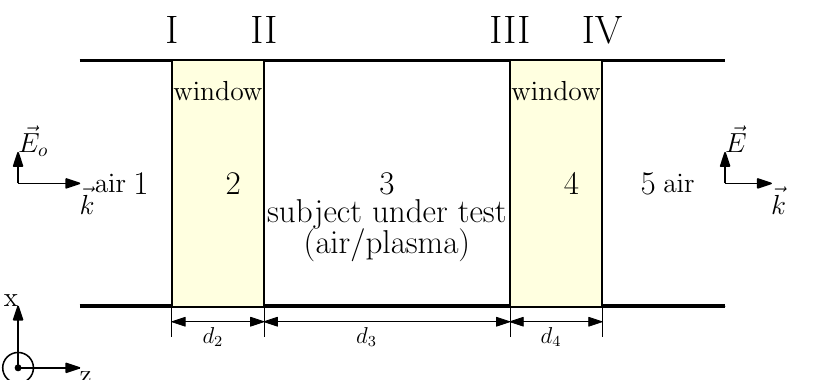
Figure 3. The simplified theoretical model of THz wave transmitting in plasma with windows. The layer order is shown in Arabic numerals, while the interface order is represented by Roman numerals. The refractive index of each layer is ˜ n i